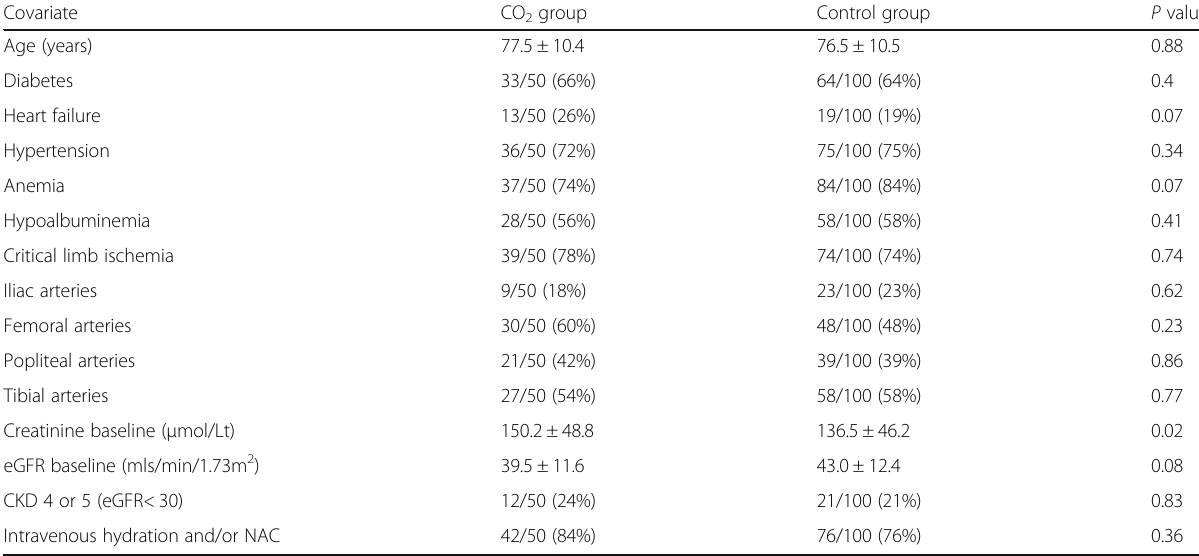
Table 1 Baseline demographics and eGFR values data